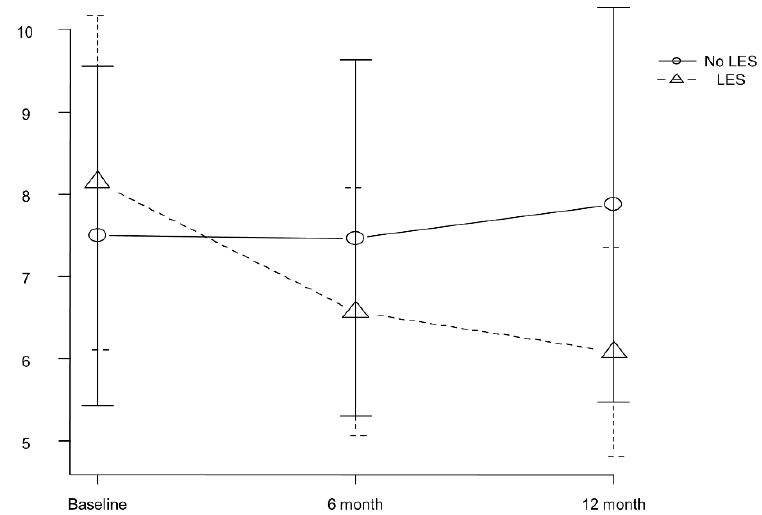
Figure 4. Changes in Child–Pugh score at baseline, 6, and 12 months in the LES and No LES groups. Data was analyzed by repeated measures ANOVA. LES, late evening snack.